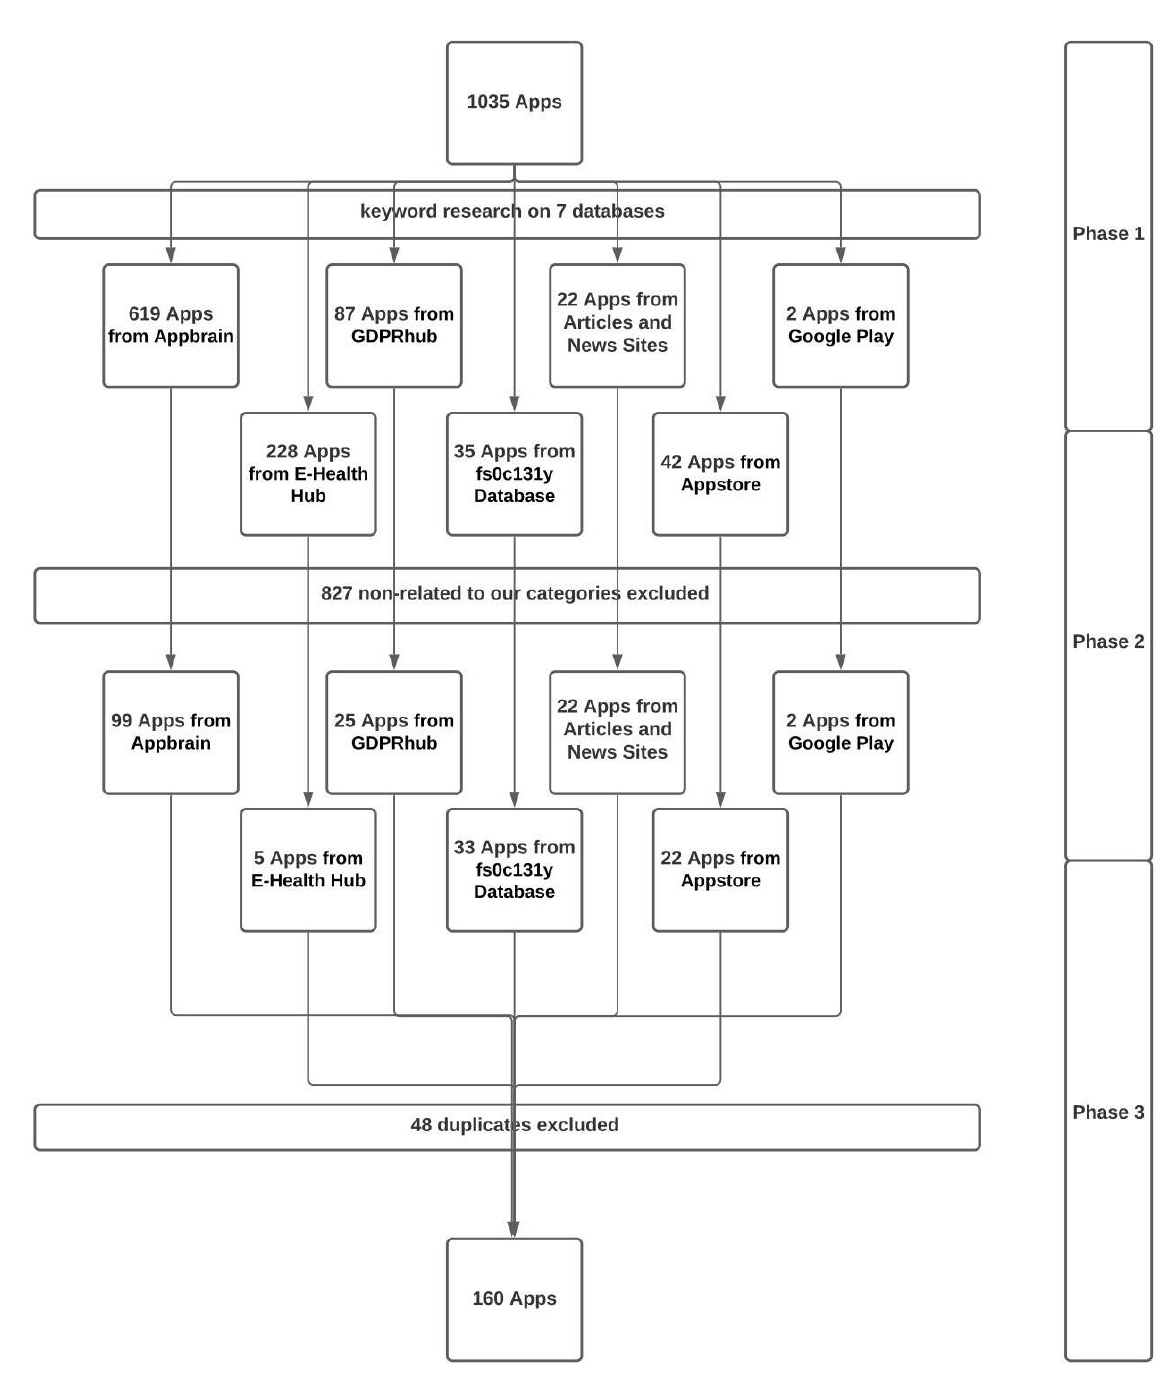
Figure 2. COVID-19 LBMAs selection.